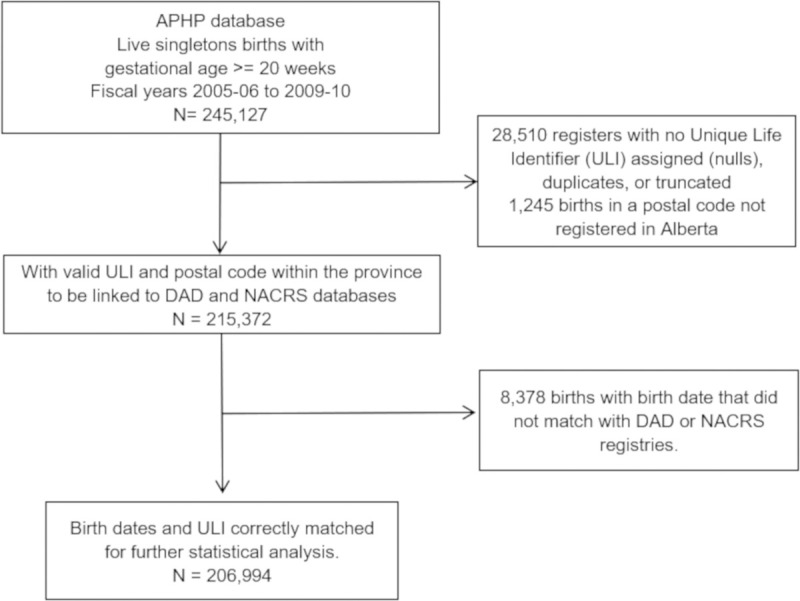
Flow diagram of assembly of the study cohort.